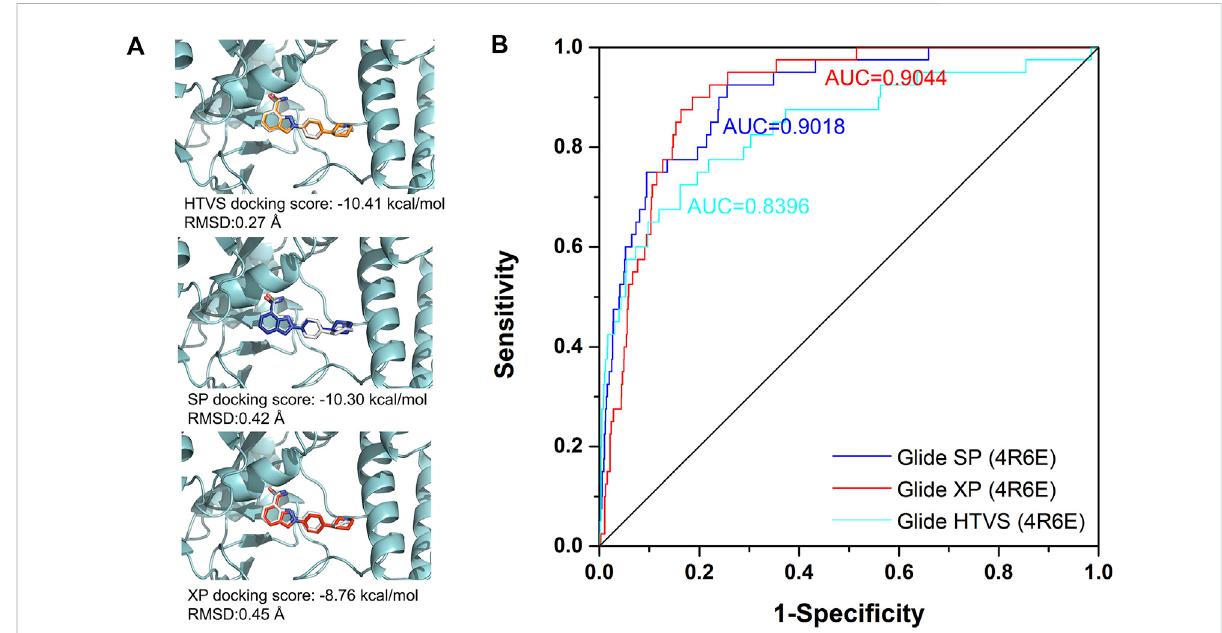
FIGURE 3 The evaluation of docking power and screening power for crystal structure in complex with Niraparib (PDB ID: 4R6E). (A) The evaluation of the docking power of crystal structure of 4R6E by HTVS, SP, and XP protocol respectively. (B) The screening power of the crystal structure of 4R6E by HTVS, SP, and XP